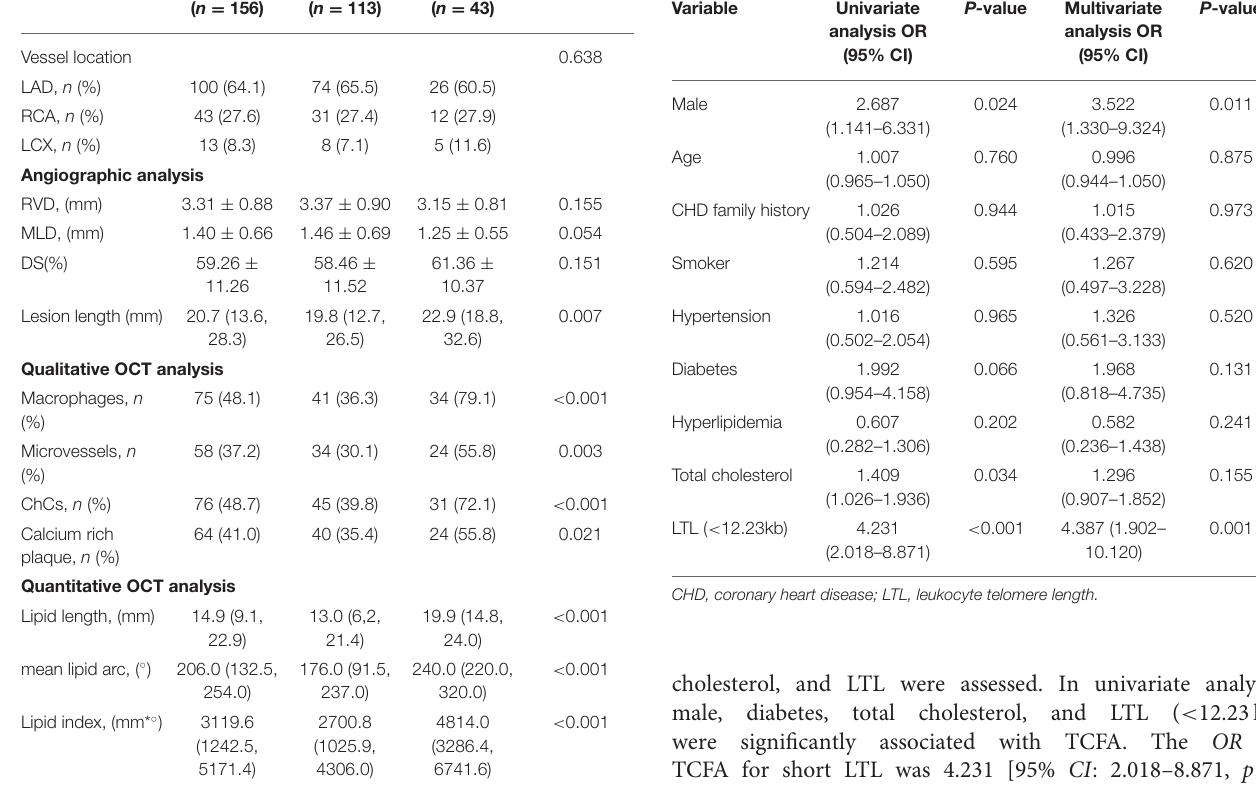
thin-cap fibroatheroma (TCFA). Variable Univariate analysis